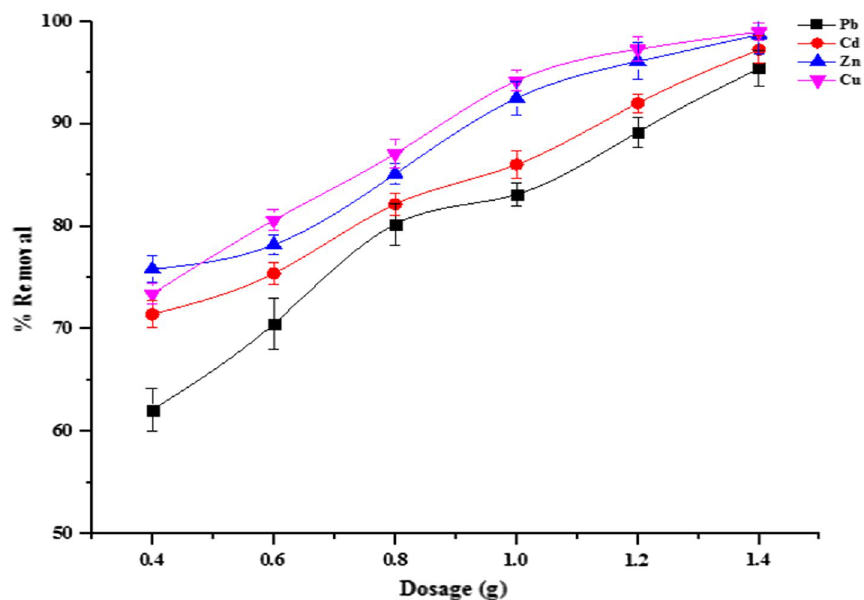
Fig. 8 Effect of